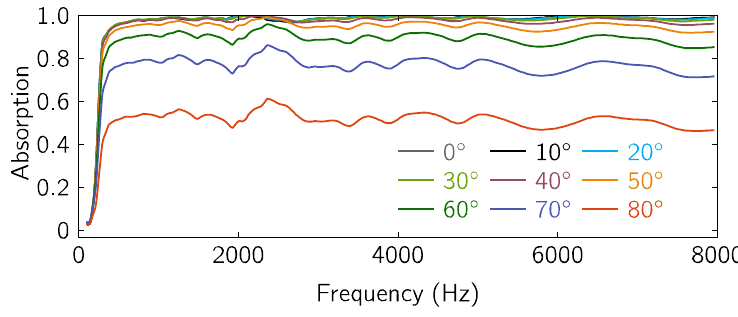
Figure A3. The absorption coefficients under different incident angles.